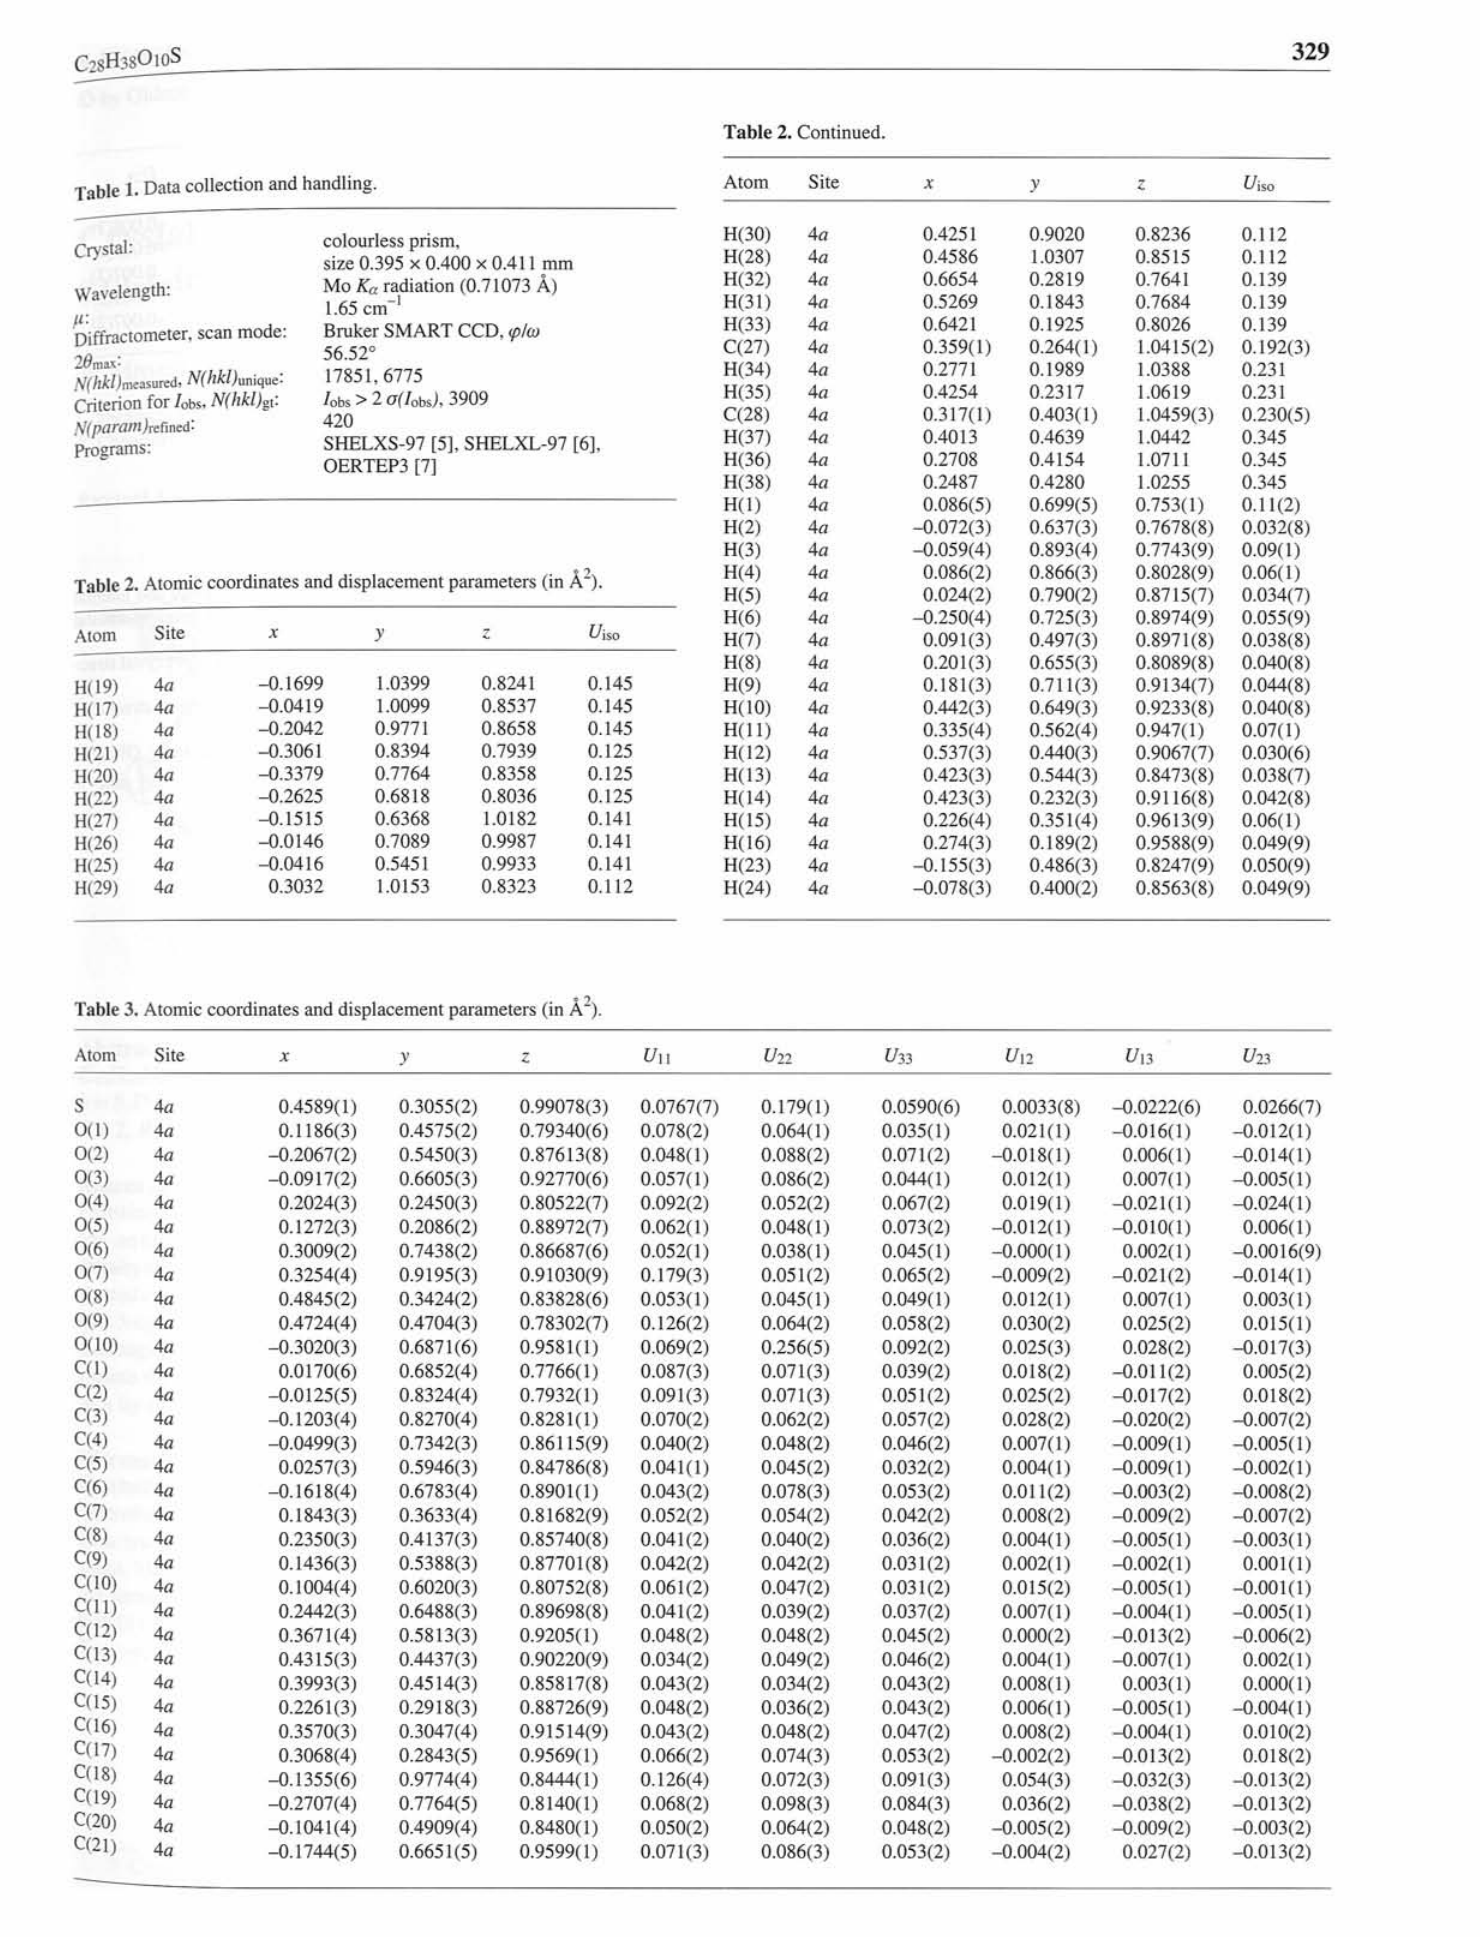
Table 2. Atomic coordinates and displacement parameters (in A").